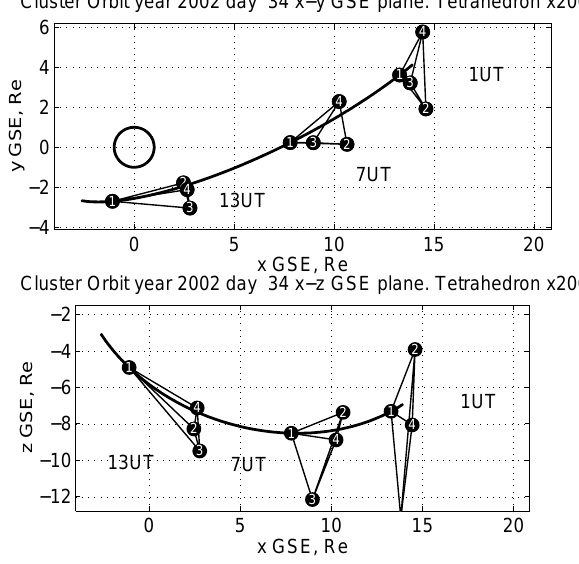
Fig. 1. Cluster orbit on day 34, 3 February 2002. Projections of the Cluster 1 orbit in the x − y (top) and x − z (bottom) GSE plane are shown. The spacecraft tetrahedron, magnified × 200, is shown at 01:00 UT, 07:00 UT and 13:00